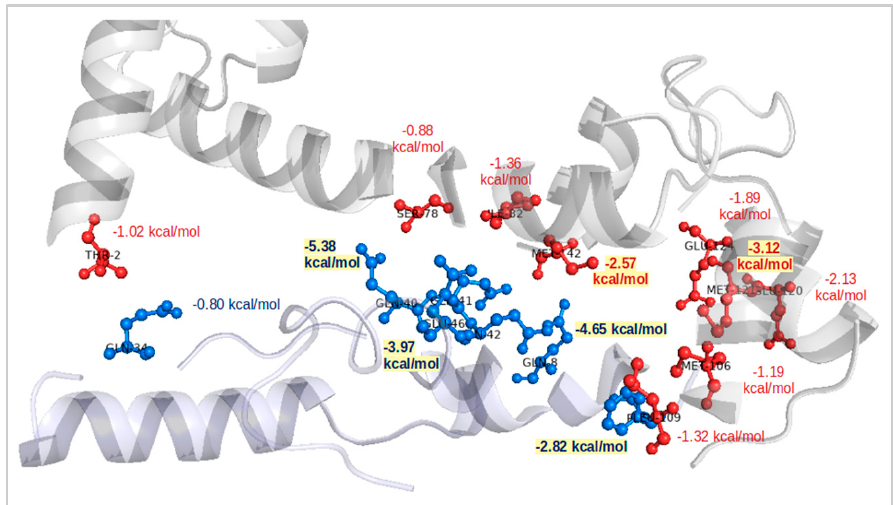
Figure 4. Per-residue contributions for CaM and 45Qs-HTT docked complex and their corresponding Figure 4. Per ‐ residue contributions for CaM and 45Qs ‐ HTT docked complex and their correspond ‐ binding free ing binding free energies.